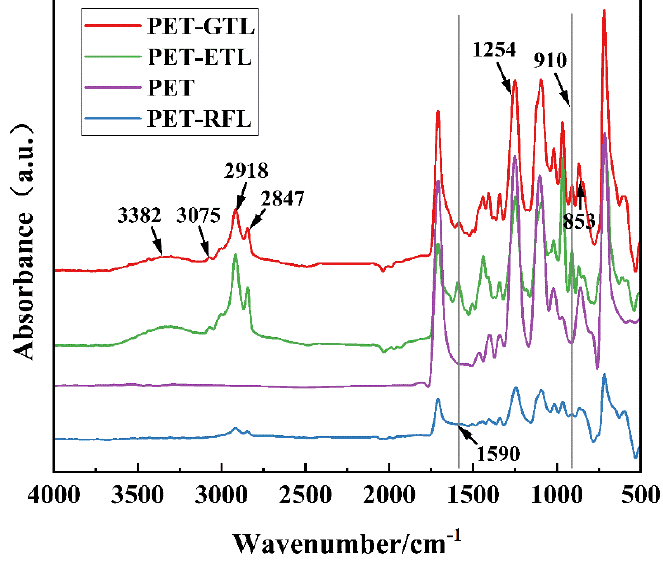
Figure 5. ATR − FTIR spectra of PET-GTL fabrics, PET-ETL fabrics, PET fabrics and PET-RFL fabrics.